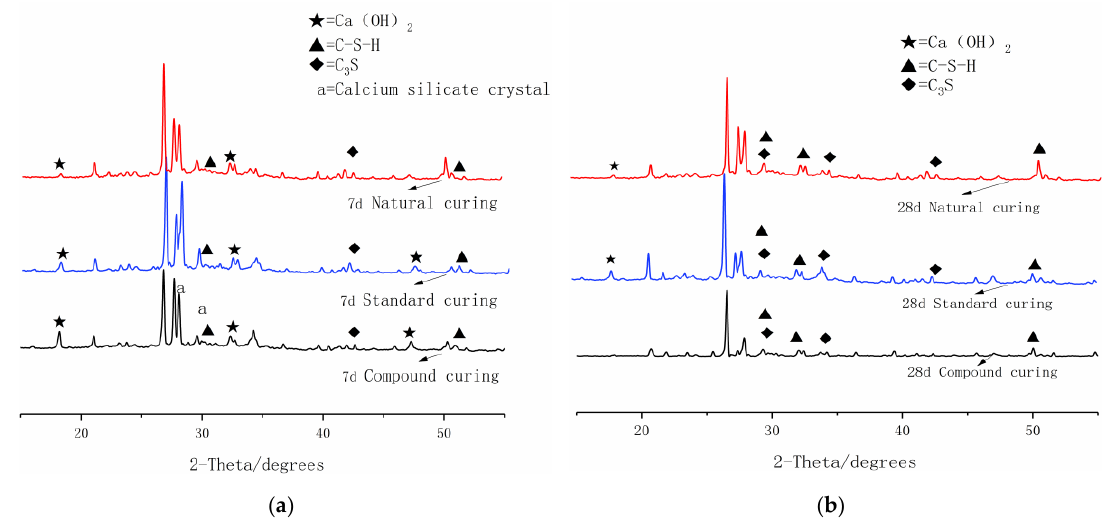
Figure 11. X-ray diffraction (XRD) analysis of three curing systems at seven days and 28 days: ( a ) Figure 11. X-ray di ff raction (XRD) analysis of three curing systems at seven days and 28 days: seven days, ( b ) 28 days. ( a ) seven days, ( b ) 28